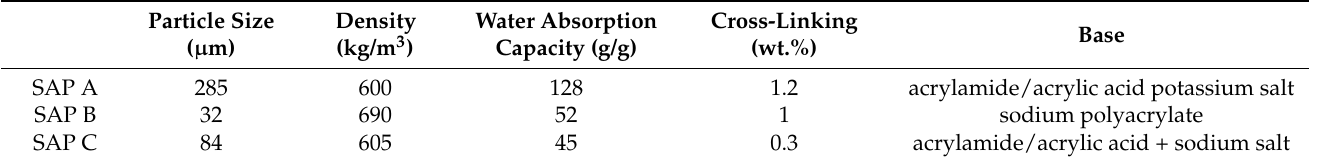
Table 1. Characteristics of used superabsorbent polymers.